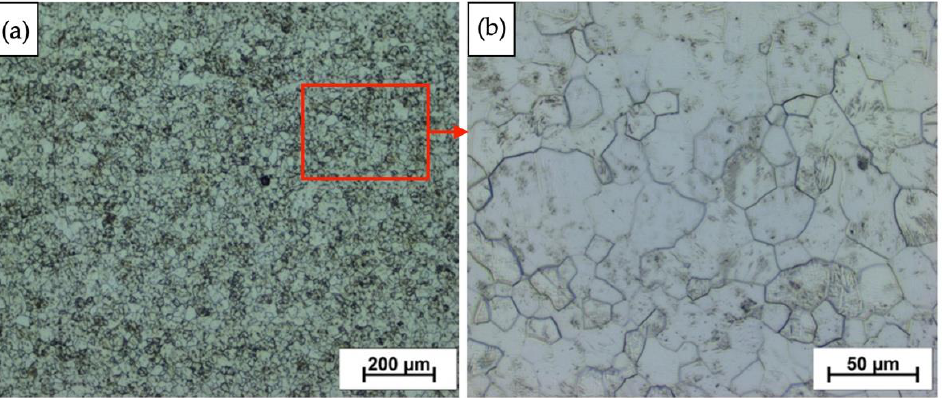
Figure 7. Initial condition after etching and before explosive hardening; grade 2 titanium with visible grain boundaries. ( a ) Macro image and ( b ) high magnification image (area indicated by the red rectangle).